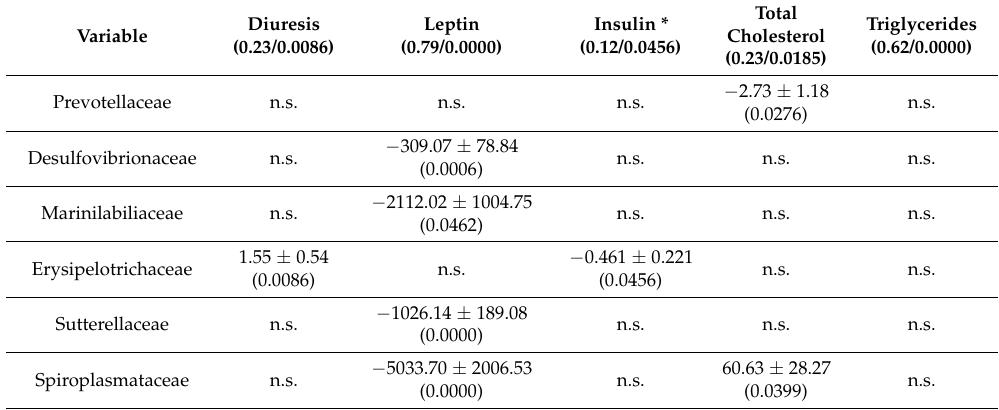
Table 3. Regression analysis for the physiological variables studied and those families with statistical differences in total percentage.